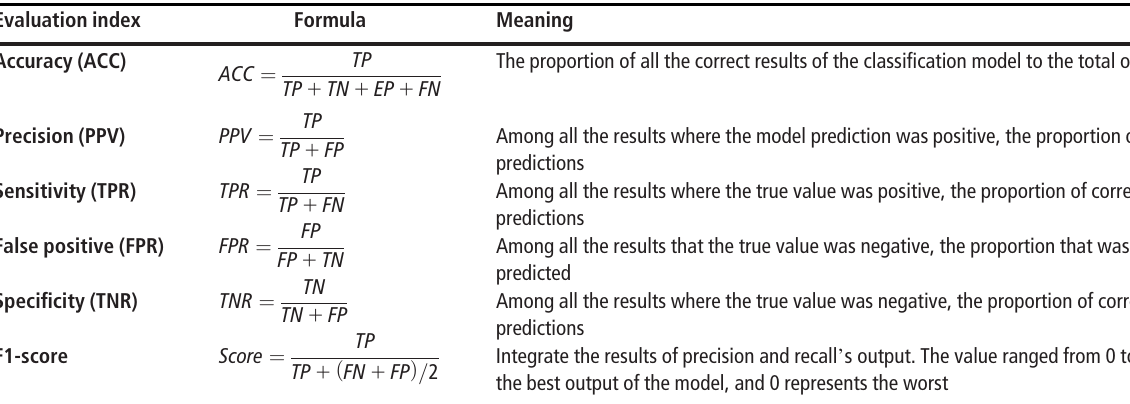
Table 6 Model prediction result evaluation